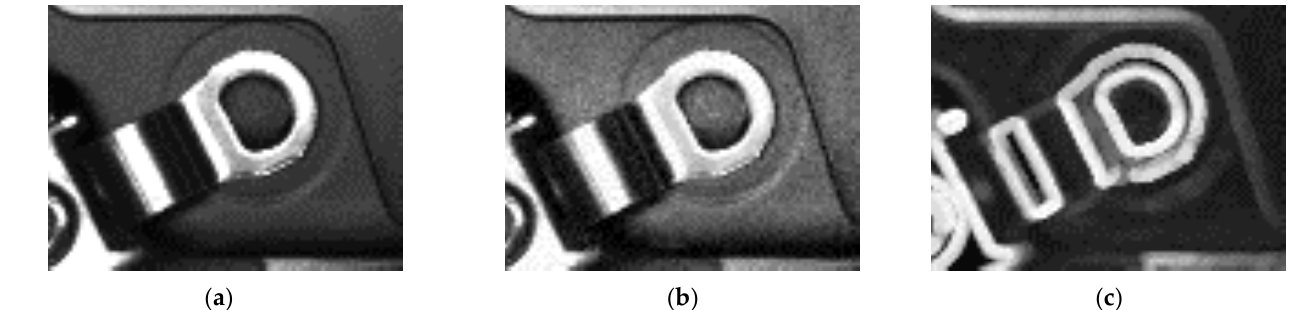
Figure 8. ( a ) Patch of the original image. ( b ) Patch of the CLAHE-applied image. ( c ) Patch of the morphological gradient- applied image.